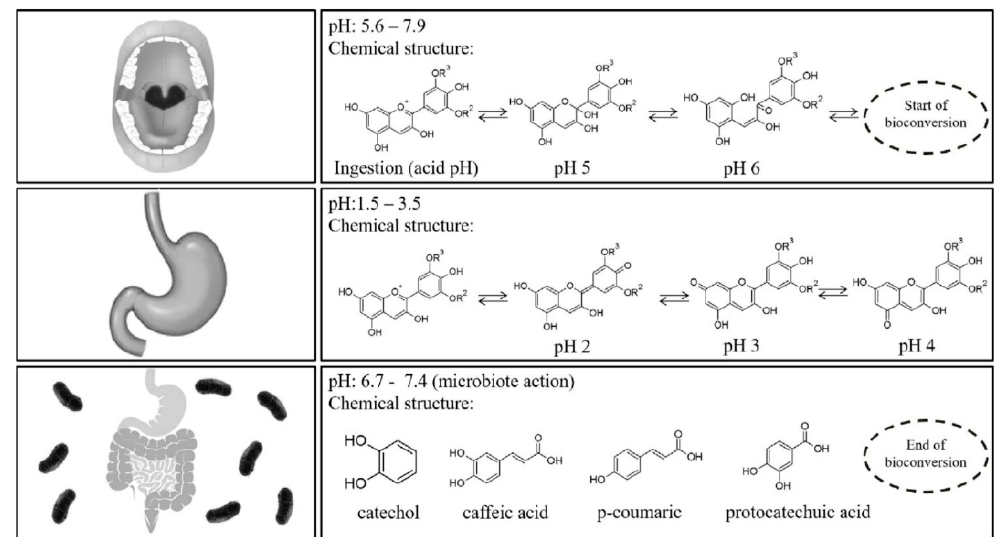
Figure 3. Schematic representation of the anthocyanins chemical structures influenced by the digestion process steps (R 2 and R 3 = H or Methyl) (taken from Braga et al. [14], with permission of Elsevier).